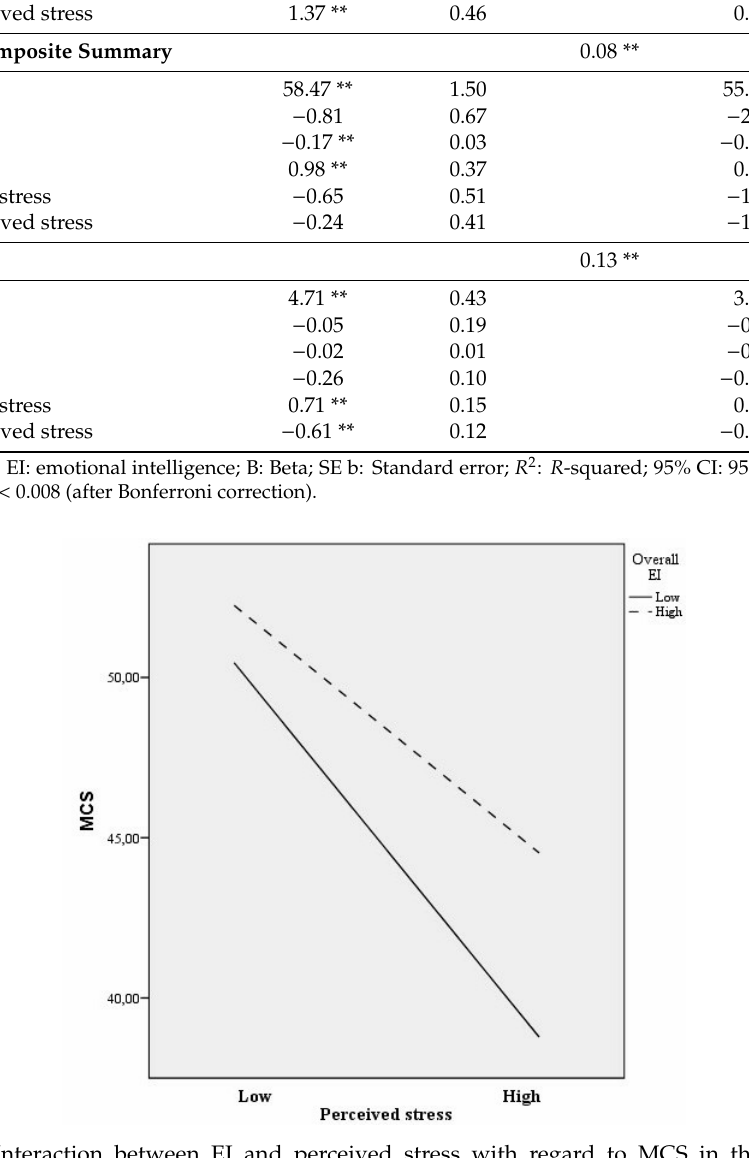
Figure 2. Interaction between EI and perceived stress with regard to MCS in the long-term unemployed